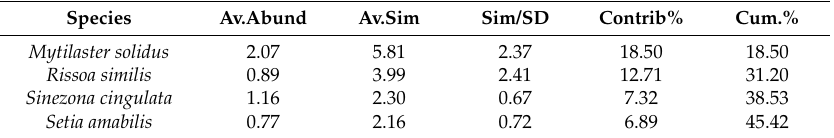
Table 6. Average abundance of the species (Av.Abund) most contributing to the Bray-Curtis similarity value among the sites, their average similarity among replicates (Av.Sim), standard deviation of similarity (Sim/SD), percentage of contribution to similarity (Contrib%), percentage of cumulated contribution to similarity (Cum.%–50% cut-off). Setia amabilis